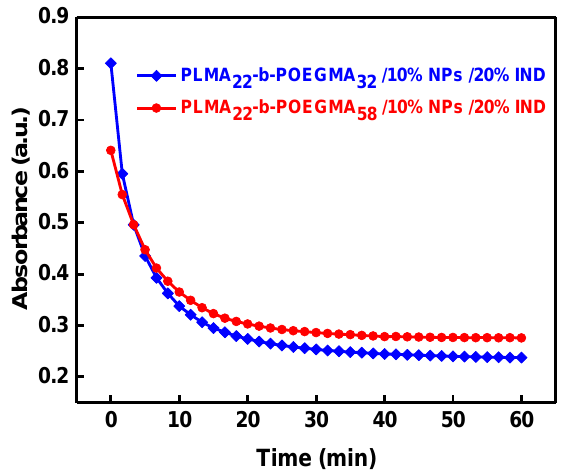
Figure 8. Magnetophoresis graphs showing absorbance as a function of time (λ = 450 nm) for PLMA 22 - b -POEGMA 58 and PLMA 22 - b -POEGMA 32 loaded with 10% magnetic NPs and 20% IND in respect to PLMA mass.